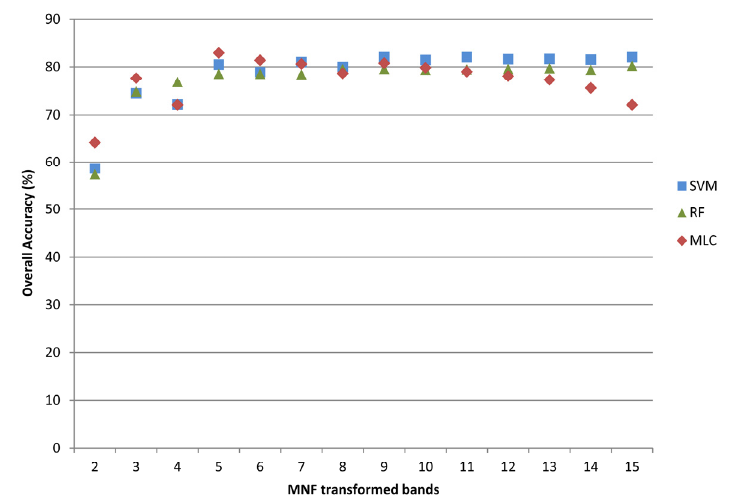
Figure 7. Overall accuracy (%) of classified image using SVM, RF and MLC with various MNF-transformed bands using 30 randomly selected training